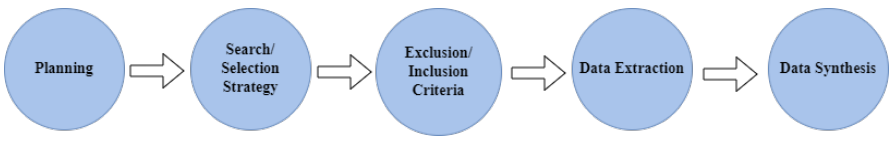
Figure 4. Planning process of systematic literature review